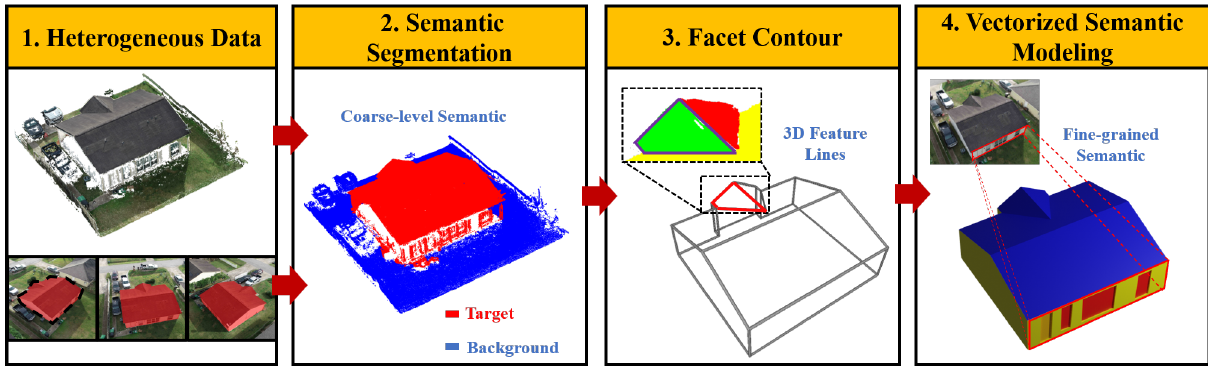
Figure 1. Overview of the proposed framework. Heterogeneous Data : Different from traditional methods, which take sparse pure LiDAR point clouds as input, our method leverages heterogeneous data including dense point clouds and multi-view images to generate vectorized fine-grained seman- tic models. Semantic Segmentation : To eliminate background and noise point clouds, coarse-level segmentation of point clouds is created from heterogeneous data in this step. Under the multi-view photometric consistency constraints and 3D co-planar geometric consistency constraints, our method is robust to common challenges in point cloud semantic segmentation, such as occlusion, dense clouds, and complex structures. Facet Contour : To represent architecture in a lightweight model instead of memory costly dense point cloud, polygon facet contour is generated from 3D feature lines which are detected from multi-view images and optimized jointly with dense point clouds of architecture. Vectorized Semantic Modeling : Aiming to produce vectorized fine-grained semantics with a lightweight model, fine-grained semantic pixels were detected from multi-view images and back-projected to the architecture surface. For a lightweight semantic representation, 3D feature lines with fine-grained pixels are leveraged to optimize the vectorized fine-grained semantic